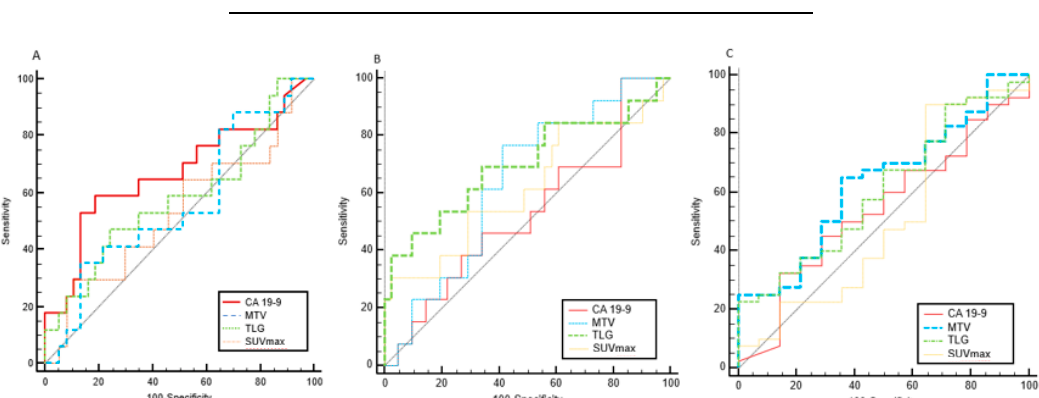
Figure 2. ROC curve comparison of predictors of Early Progression (EP) ( A ), Local Progression (LP) ( B ), and Overall Survival (OS) ( C ). The variables analyzed were CA 19-9 levels, the metabolic tumour volume (MTV), the total lesion glycolysis (TLG) and the maximum standardized uptake value (SUVmax) of primary tumour.